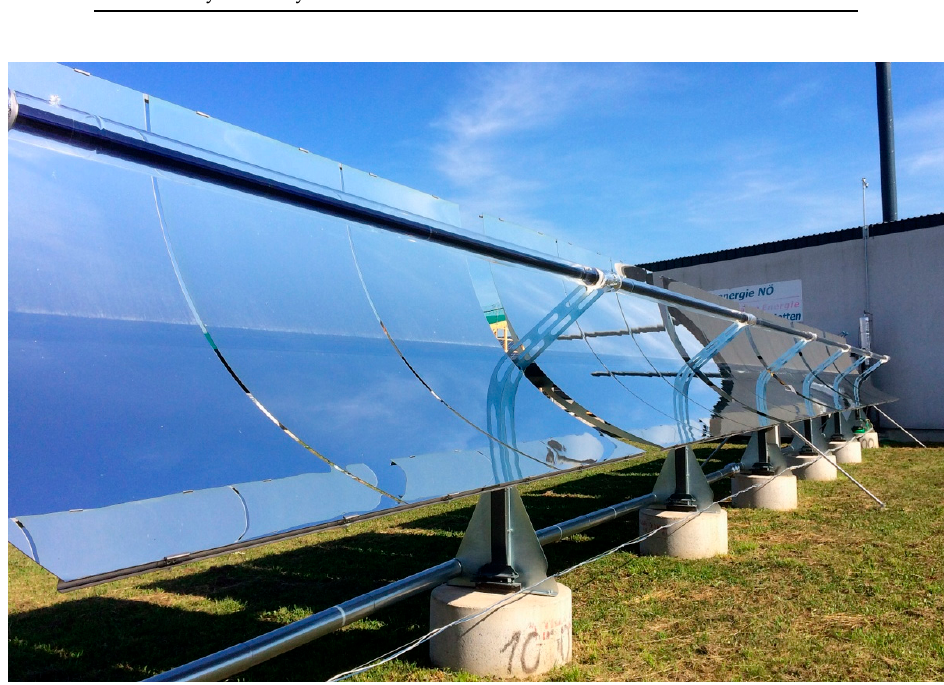
Figure 4. Solar–thermal power plant for district heating using IMK Solarmirrortec SMT-8 parabolic trough modules in Seitenstetten, Austria.